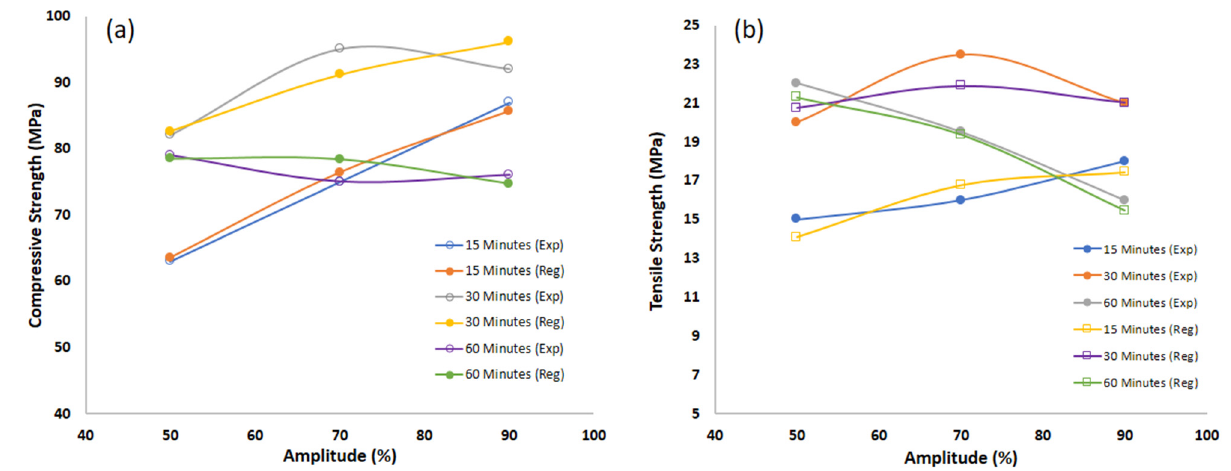
Figure 9. The comparison between the experimental and regression values of ( a ) compressive strength and ( b ) tensile strength at varying amplitudes and times.